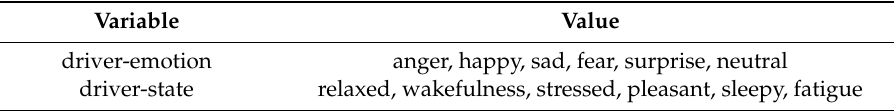
Table 9. Description of the output fuzzy variables.